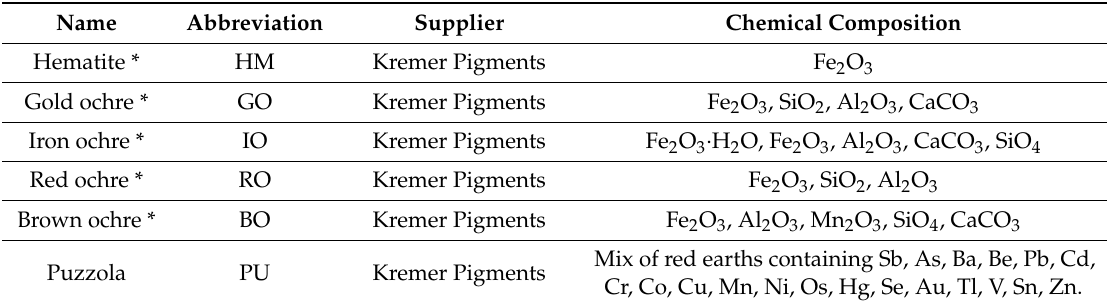
Table 1. Description of earth pigments applied in the